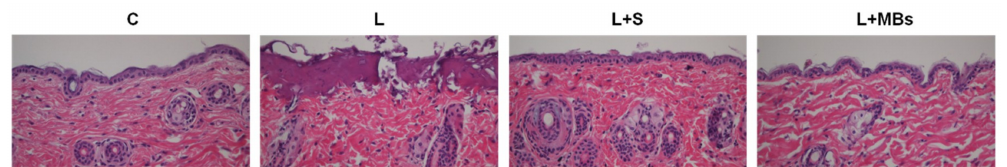
Figure 7. Light-microscope hematoxylin and eosin (HE) evaluation of pigskin samples in group C, for irradiation with the CO 2 fractional pulsed laser directly (group L), and for laser irradiation combined with saline (group L + S) and tenfold-diluted MBs (group L + MBs).